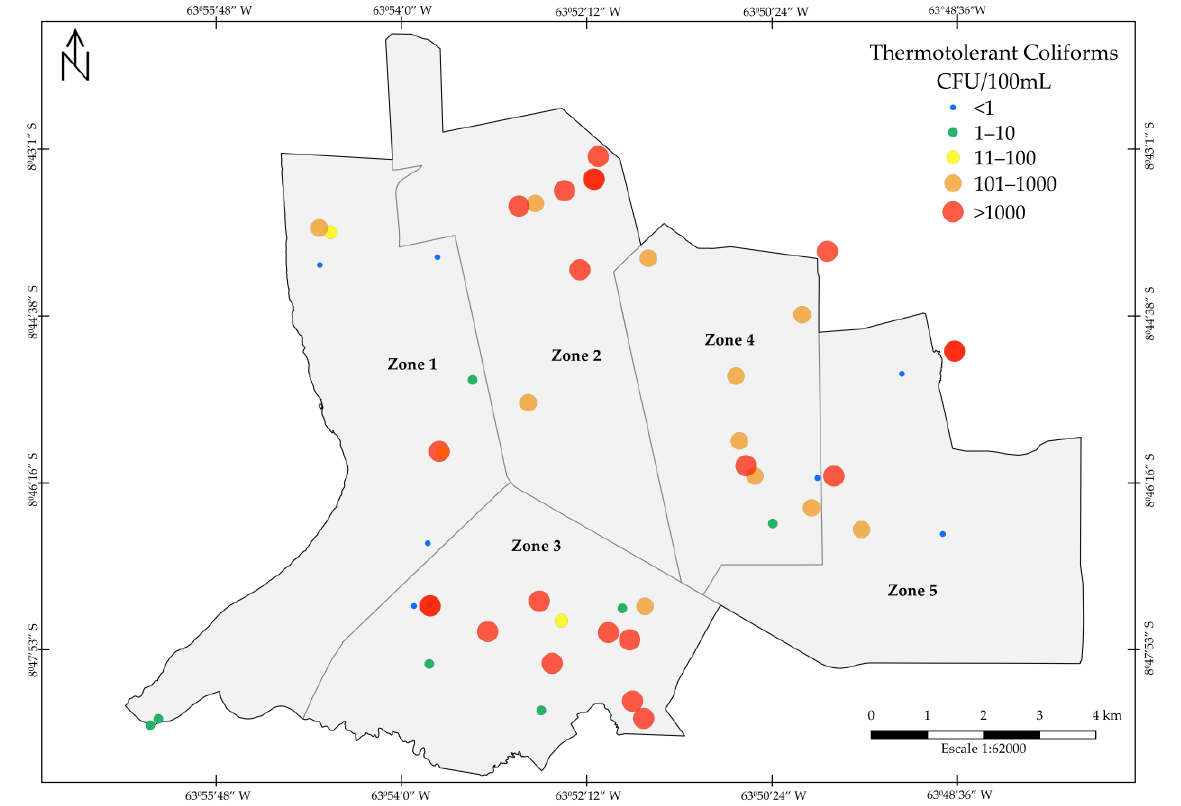
Figure 5. Spatial distribution of thermotolerant coliforms in groundwater in Porto Velho, RO.